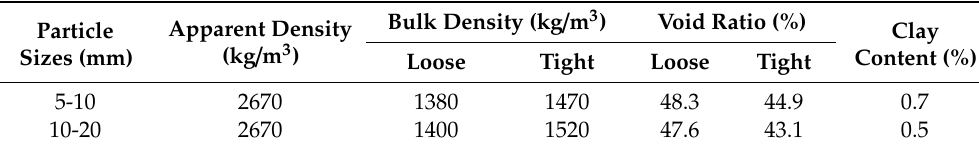
Table 5. The basic performance of crushed limestone.